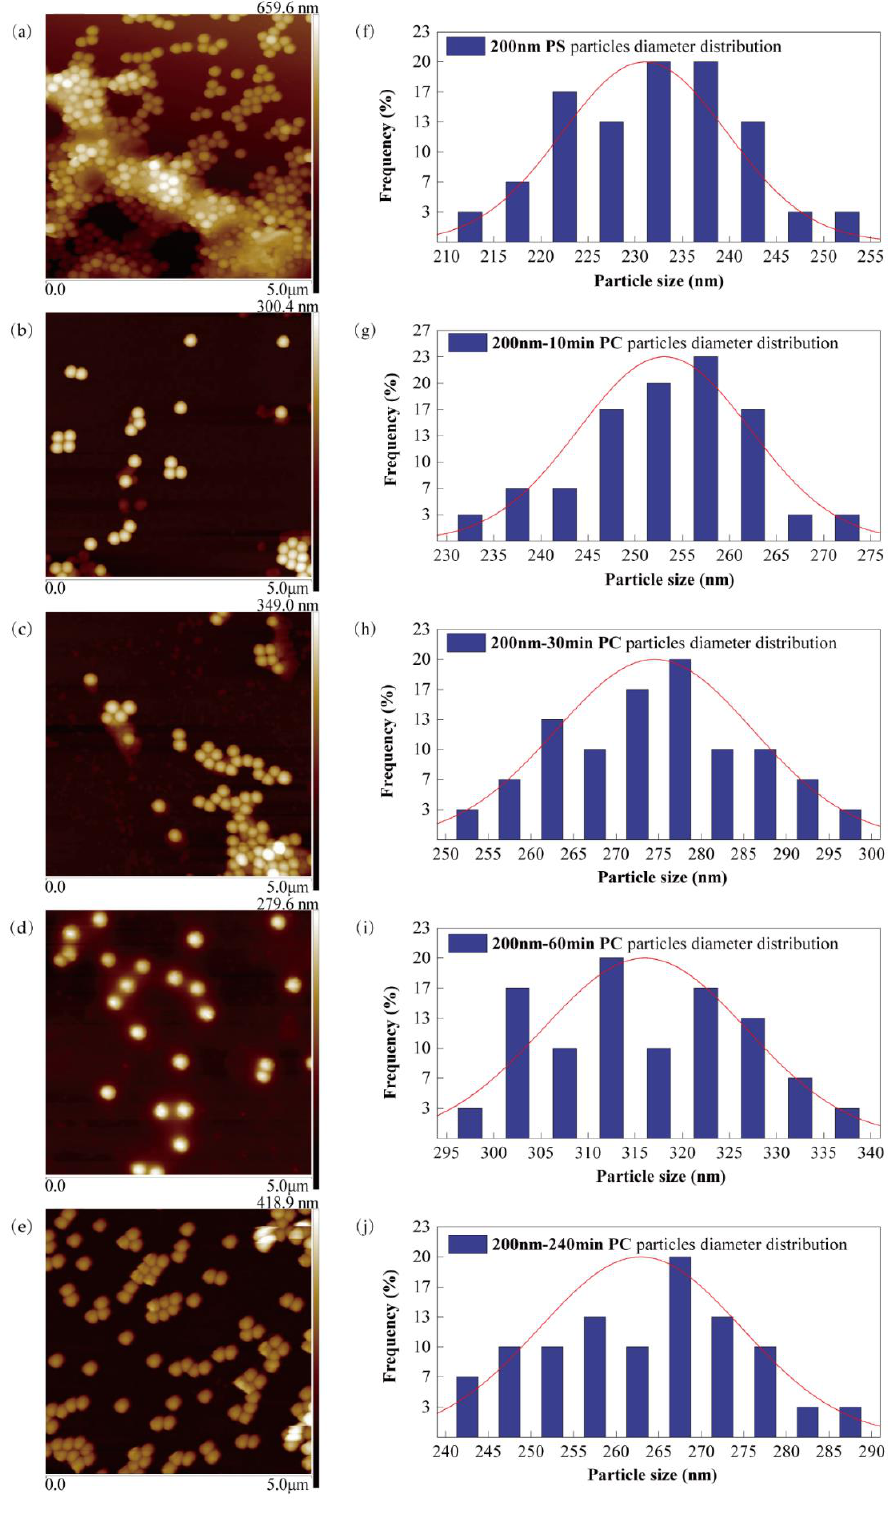
Figure 2. AFM images and diameter distribution of PS NPs ( a , f ) and PS-HRP PC incubated for 10 min ( b , g ), 30 min ( c , h ), 60 min ( d , i ), and 240 min ( e , j